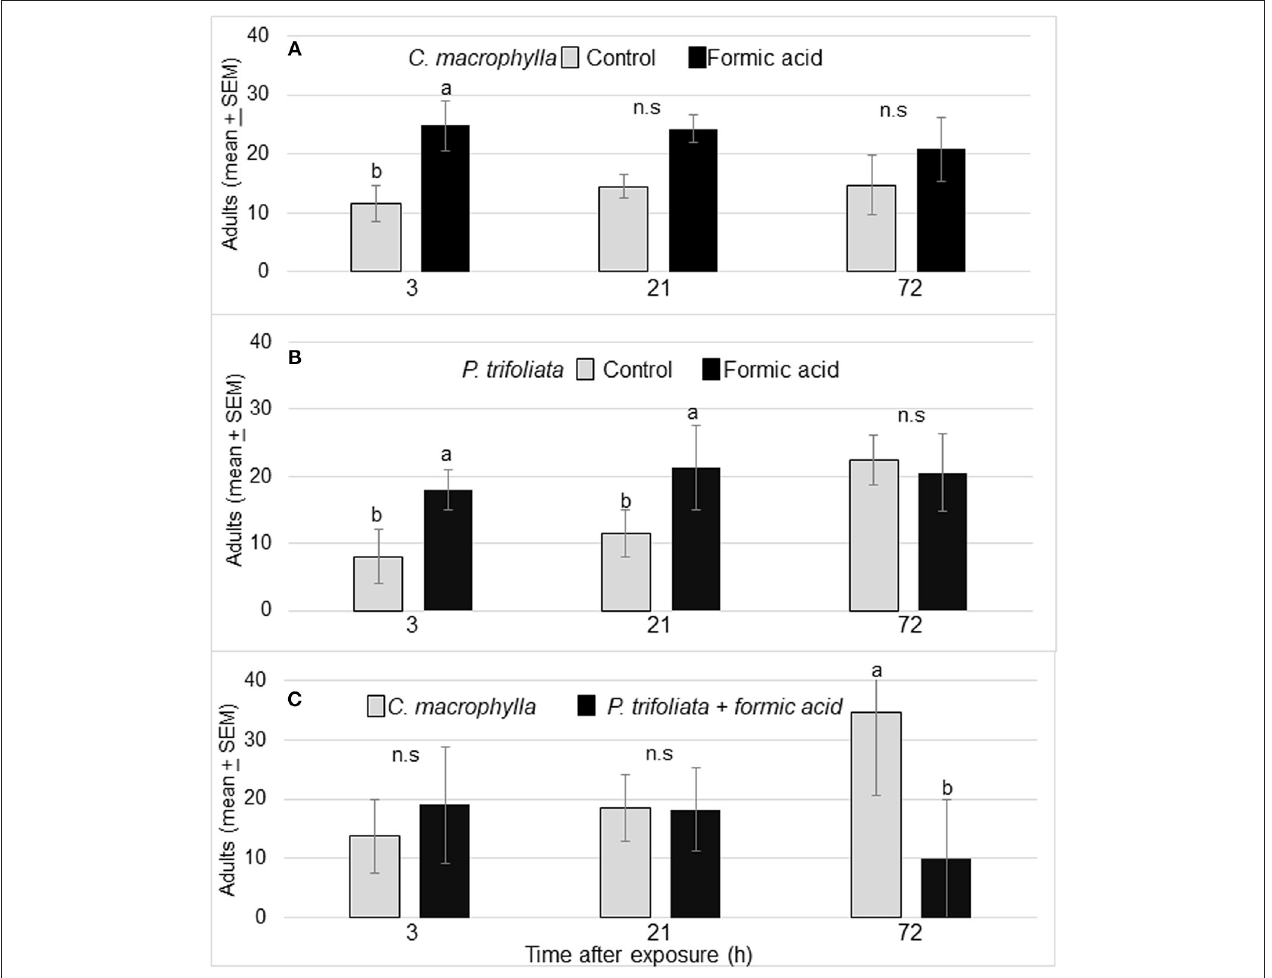
FIGURE 2 | (A) Mean ( ± SEM) no. of D. citri on control and formic acid-exposed C. macrophylla at 3, 21, and 72h after exposure. (B) Mean ( ± SEM) number of psyllids on exposed P. trifoliata (Towne-G) vs. unexposed P. trifoliata plants. (C) Mean number ( ± SEM) of D. citri adults on C. macrophylla vs. P. trifoliata (Towne-G) plants exposed to formic acid. Means followed by the same letters do not differ by Tukey’s HSD following a significant ANOVA ( α = 0.05, n =